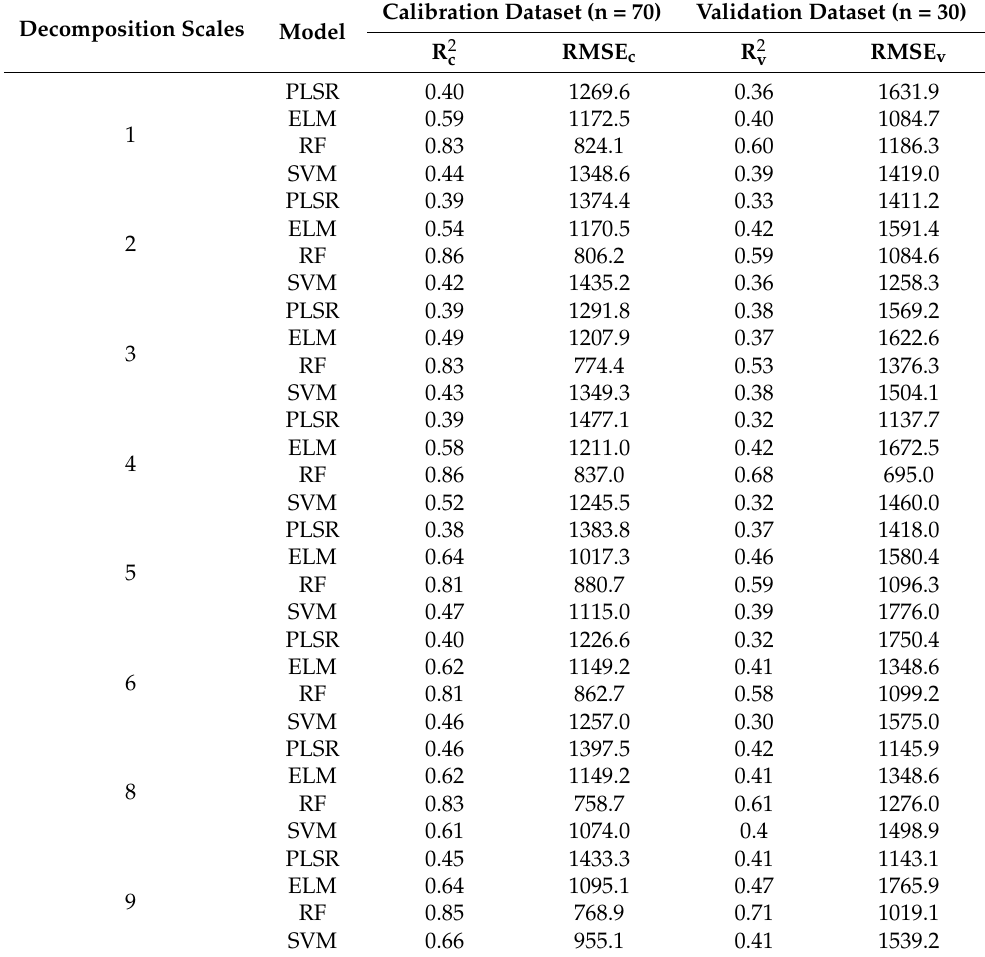
Table 4. Accuracy evaluation for inferring Fe concentration using PLSR, ELM, RF, and SVM models based on